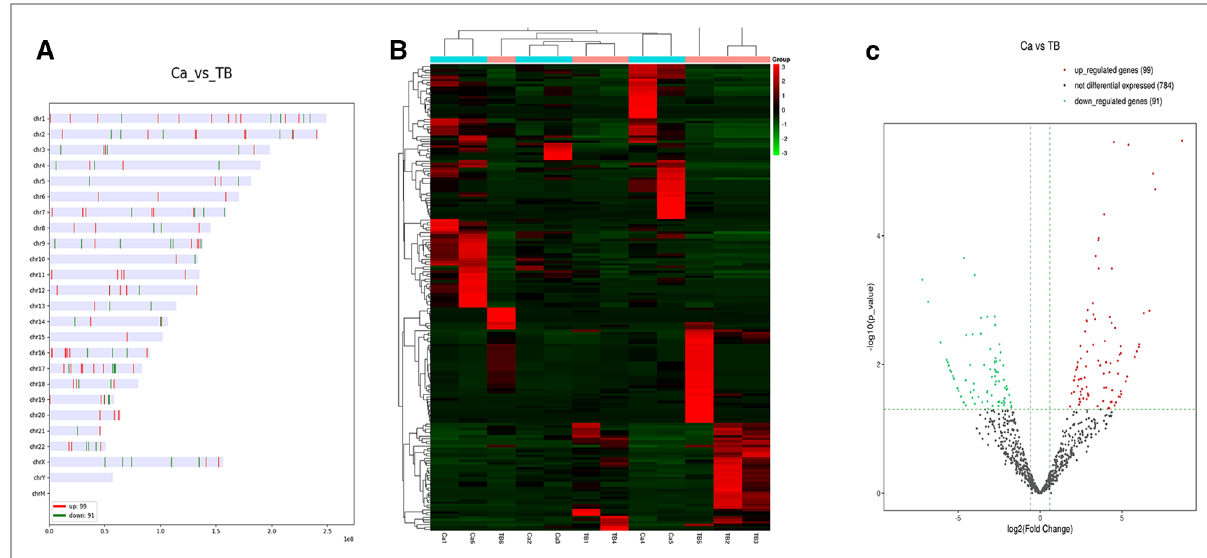
FIGURE 2 The distribution, heatmap, and volcano plot of DEmiRNAs. ( A ) The distribution of DEmiRNAs. ( B ) Heatmap of DEmiRNAs. ( C ) Volcano plot of DEmiRNAs.